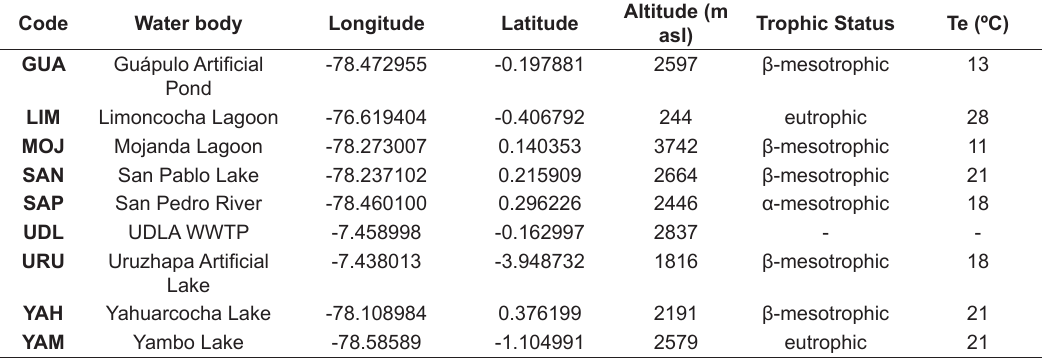
Table 1. List of the sampling sites along with the name code, type of water body, longitude, latitude, and altitude. In meters above sea level (m asl), trophic status and temperature